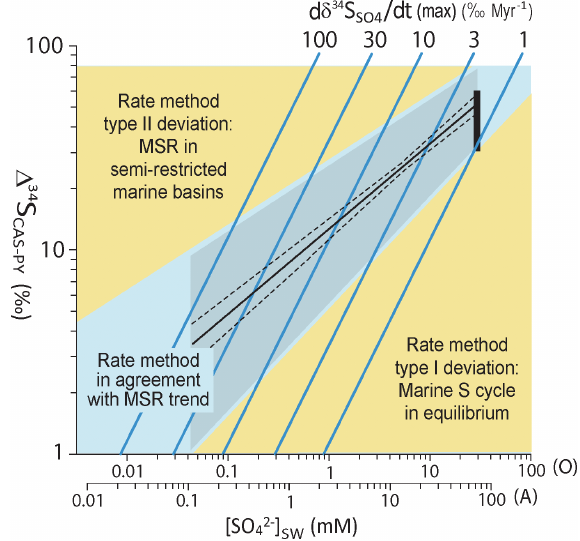
Figure 9. Interpretation of deviations in [SO 2 − ] SW estimates be- 4 tween the rate and MSR-trend methods. Type I deviations, in which rate-method estimates are anomalously high (lower right field), are likely to reflect extremely stable environmental conditions, in which the marine sulfur cycle is in equilibrium (i.e., balanced source and sink fluxes). Type II deviations, in which rate-based estimates are anomalously low (upper left field), are likely to reflect sulfate re- duction in semi-restricted marine basins. In this case, (cid:49) 34 S CAS-PY will be controlled by [SO 2 − ] SW , which may be equal or close to 4 that of the global ocean, but ∂δ 34 S CAS /∂t (max) will be controlled by the mass of aqueous sulfate within the restricted basin, which will be a function of basin